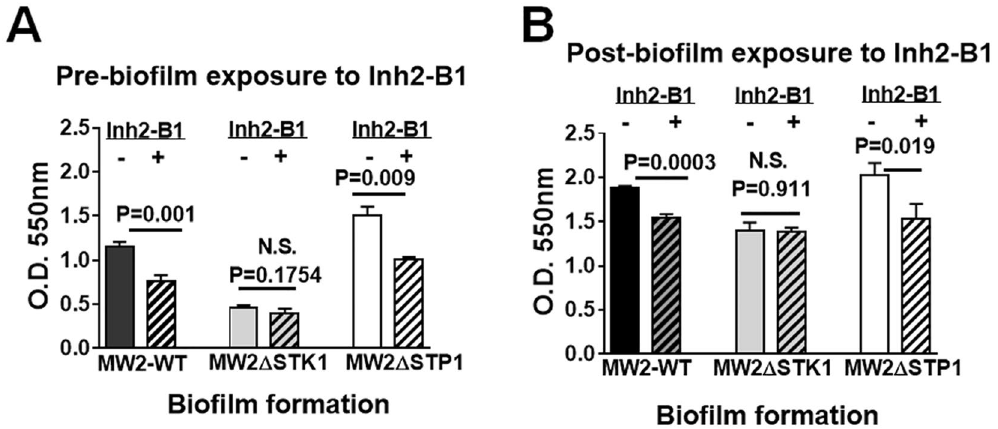
Figure 6. Inh2-B1 disrupts the formation S . aureus biofilms. ( A ) Biofilms formation by S . aureus MW2 wild- type, MW2 Δ STK1 and MW2 Δ STP1 mutant strains in the absence and presence of 25 µ M Inh2-B1 after 48 h. ( B ) Effect of Inh2-B1 (25 µ M) on the preformed biofilms by S . aureus MW2 wild-type, MW2 Δ STK1, and MW2 Δ STP1 mutant strains. Biofilm formation was quantitatively estimated after 48 h of incubation by the crystal violet staining method. Bar diagrams represent average values (Mean ± S.D) obtained for different parameters from three independent cultures each with three technical replicates. P < 0.05 was treated as a significant